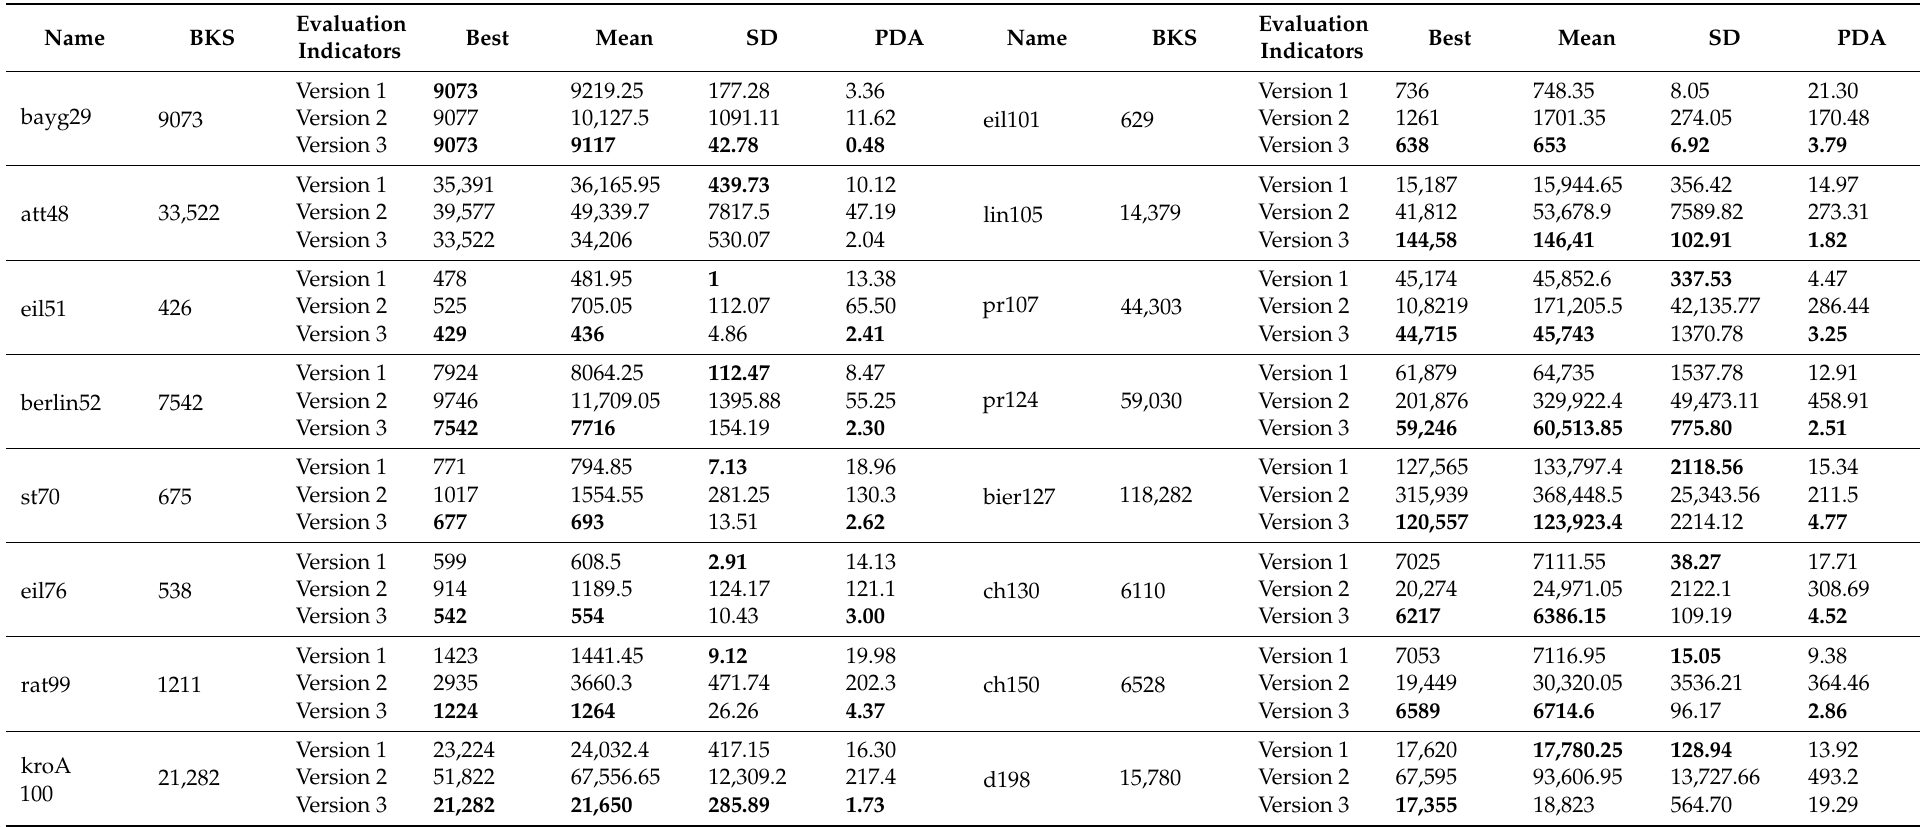
Table 6. Comparison of the proposed individual-generated method with the other two individual-generated